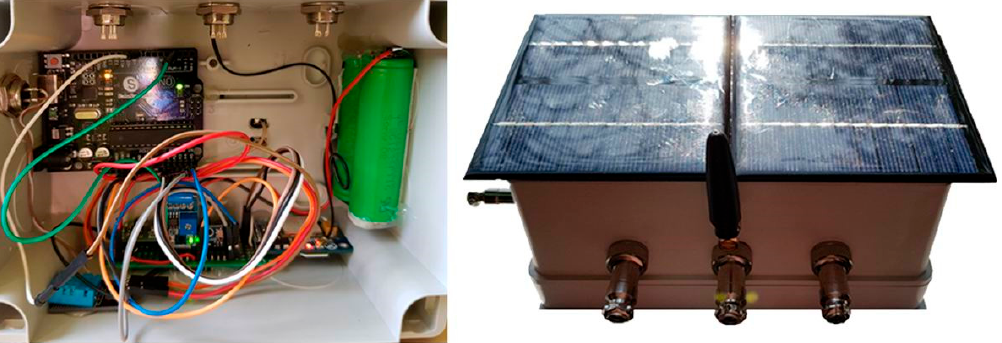
Figure 10. AMS: Arduino microcontroller with electronic components ( left ) and layout of ports and solar panels ( right ). Reproduced with permission from [37], Singidunum University.